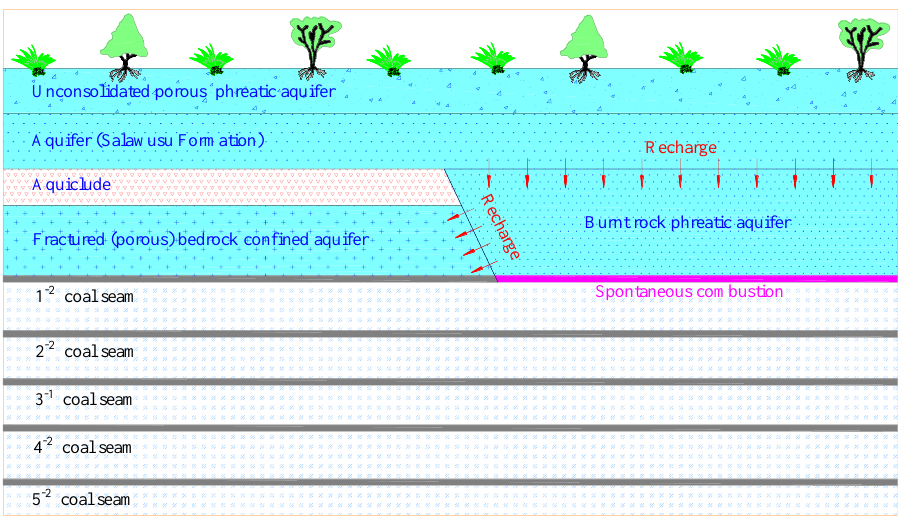
Figure 5. The major types of aquifers in the Yu-Shen mining area.